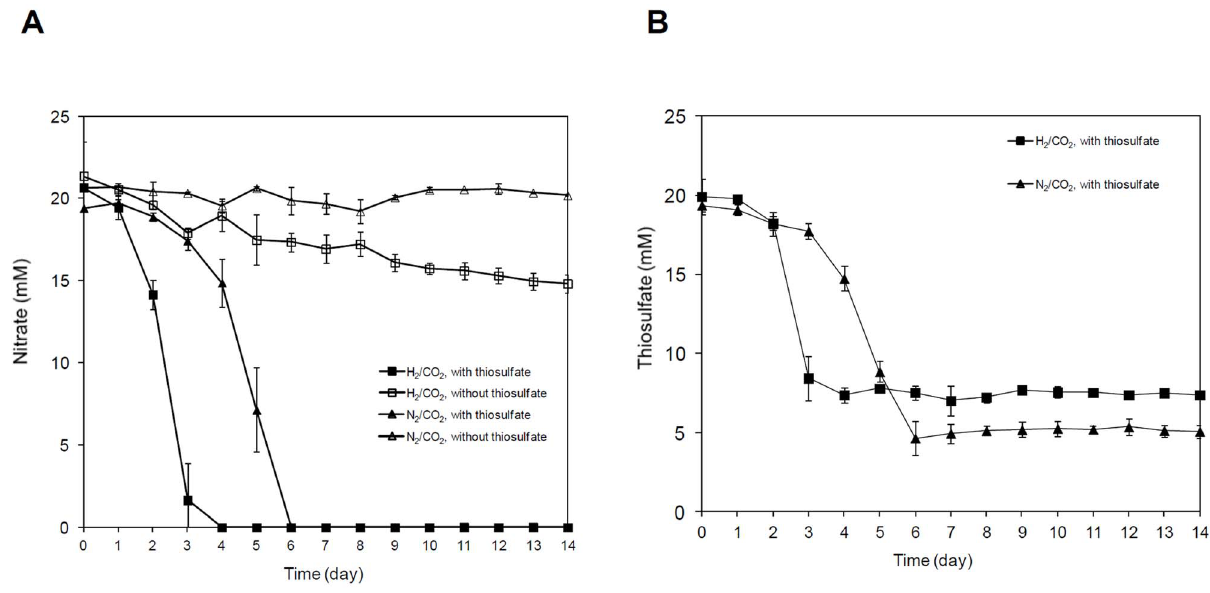
Figure 3. Nitrate (A) and thiosulfate (B) consumption of S. denitrificans DSM-1251 under different cultivation conditions. S. denitrificans DSM-1251 cells were grown in DSMZ medium 113 containing thiosulfate (18.8 mM, filled marker) or without thiosulfate (open marker). The headspace was completely exchanged with H 2 /CO 2 (80%/20%) (square) or with N 2 /CO 2 (80%/20%) (triangle). Error bars indicate the standard deviations from measurements of three cultures.